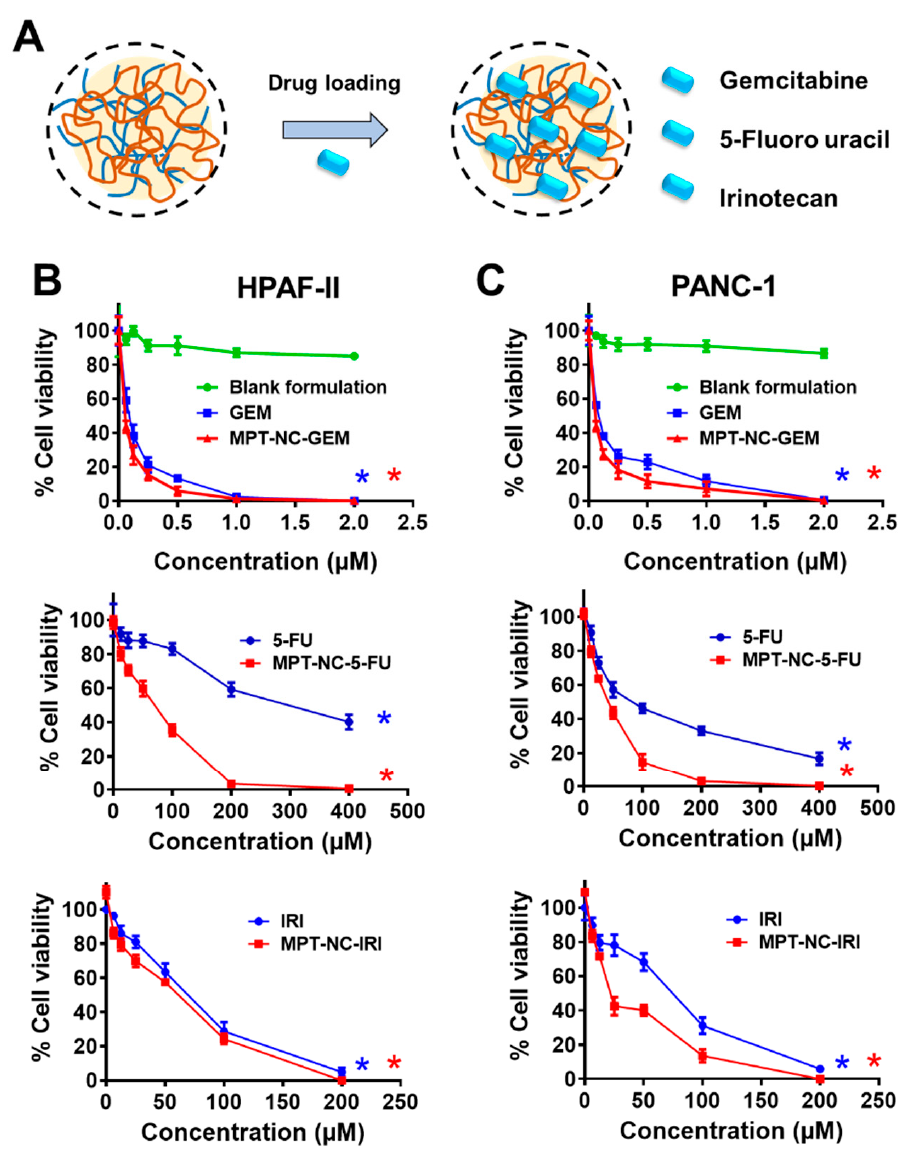
Figure 5. Anti-cancer potential of MPT-NCs against pancreatic cancer cell lines. ( A ) Schematic illustration of drug loading procedure in MPT-NCs. ( B , C ) Cell viability of HPAF-II and PANC-1 as a function of GEM, 5-FU, and IRI concentration and drug containing MPT-NCs. * p < 0.05 of GEM, 5-FU, and IRI concentration and drug containing MPT-NCs compared to un-treated / control cells. Data are presented as the mean ± SD, n =